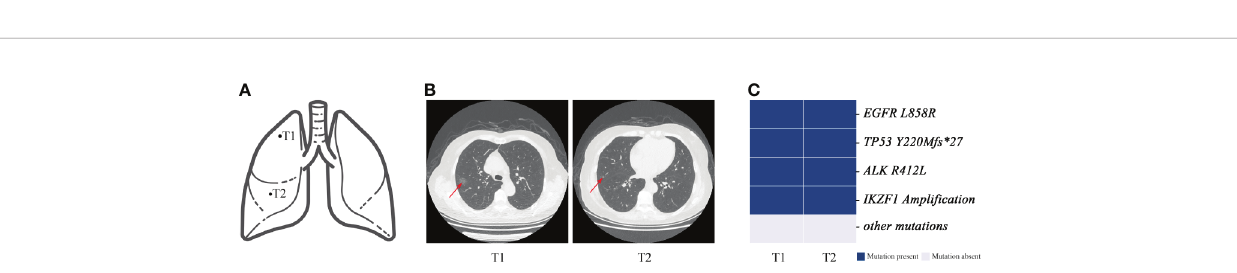
FIGURE 7 | Genomic mutations and computed tomography (CT) images of patient 9. Patient 9 was classi fi ed as having MPLC using the Martini and Melamed criteria. The lesions of the patient were found to have multiple consistent mutation sites and were diagnosed as IM by mutation evaluation. (A) Schematic diagrams of lung lesions. (B) and (C) Corresponding CT images and mutation distributions of patient